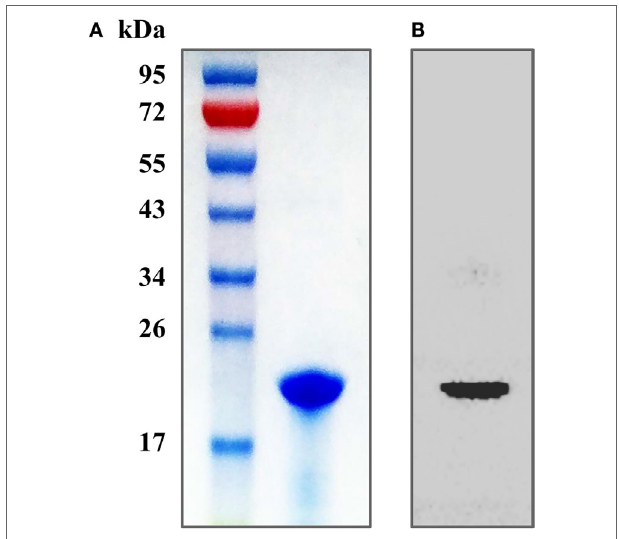
FigUre 1 | Purification of the recombinant HP1330 protein. (a) SDS-PAGE analysis. (b) Western blot analysis, the blot was probed with an anti-His tag monoclonal antibody